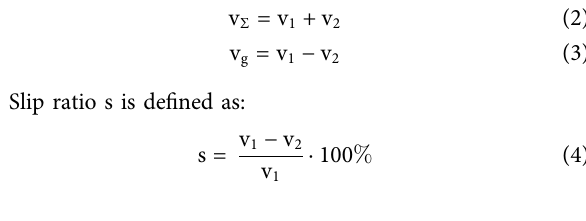
Frontiers in Mechanical Engineering |